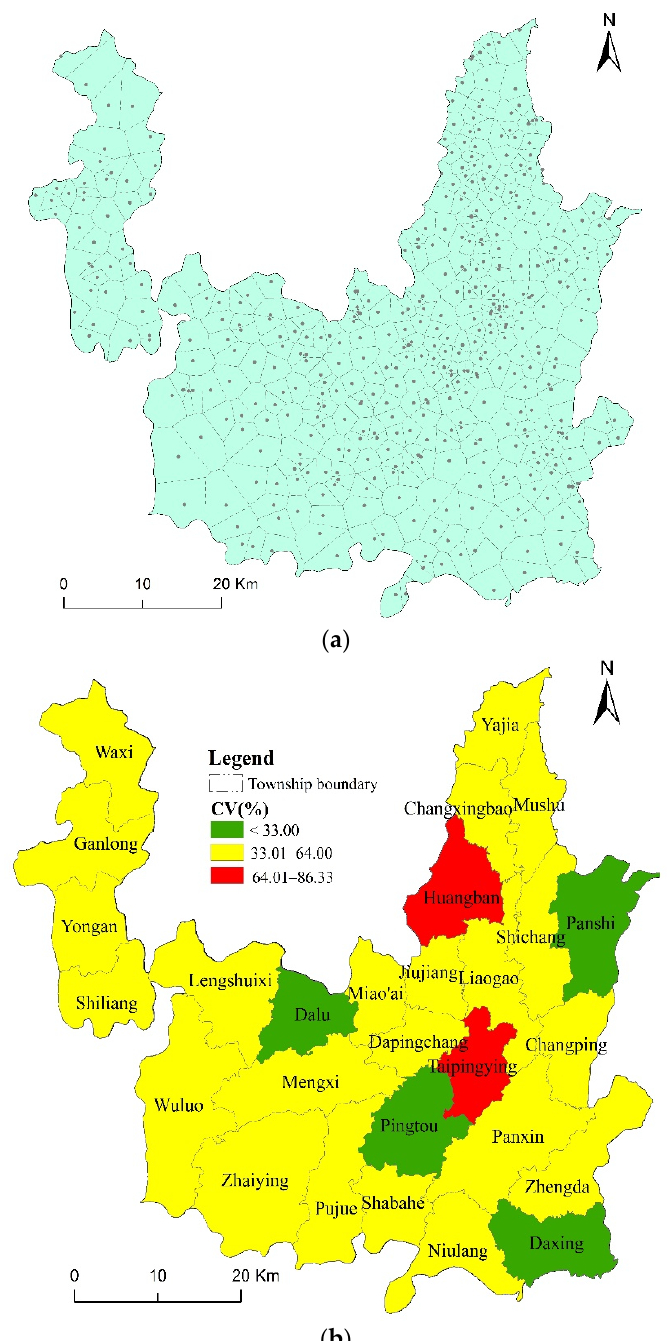
Figure 3. Thiessen polygon and its area variation coefficient of rural settlements in study area. ( a ) The Thiessen polygon of rural settlements in the study area; ( b ) The coefficient of variation of rural settlements